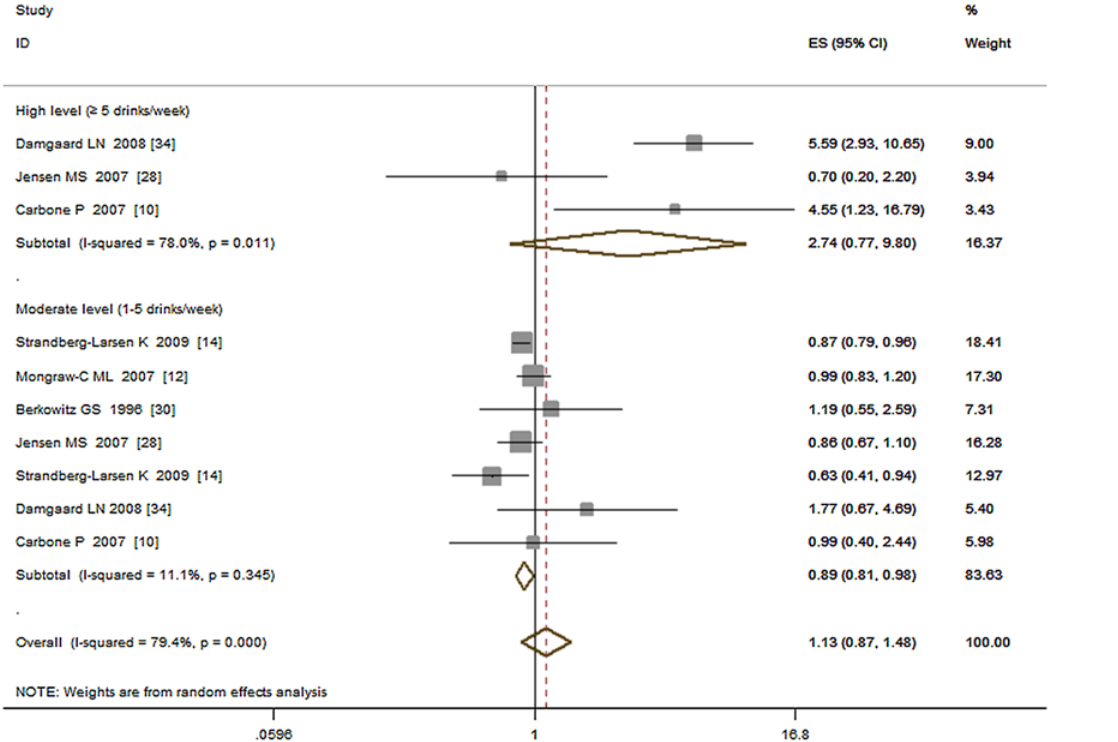
Fig 6. Forest plot for high and moderate vs. low exposure level of alcohol.